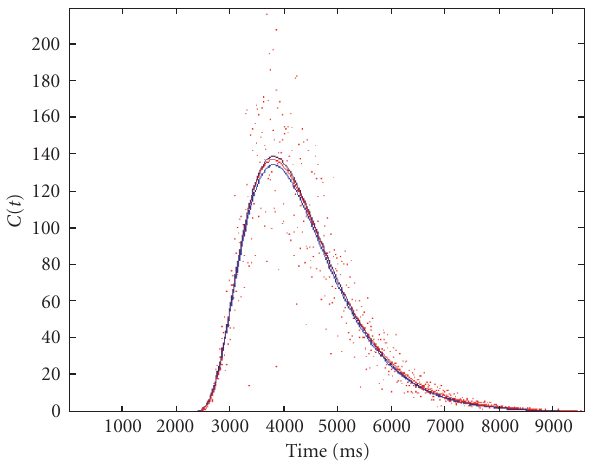
Figure 9: Simulation of the fitting. The dots and the upper curve represent the LDRW model ( λ = 5) with and without added noise ( k = 1 / 16), respectively. The mid and the lowest curves are the LDRW fit of the noise-added curve with and without area compen- sation.